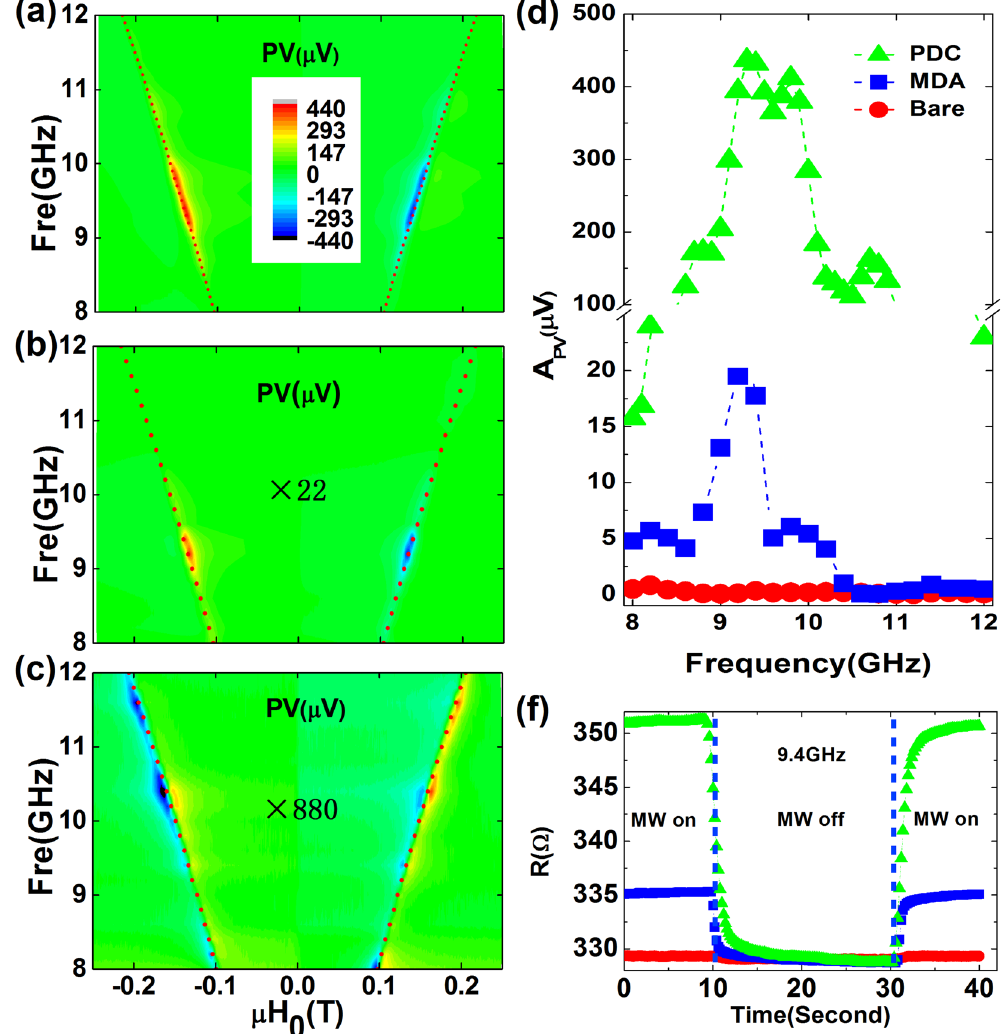
Figure 2. Experimental results. Panels (a)–(c) successively show the two-dimensional PV spectrum as a function of the external magnetic field and microwave frequency for three configurations: PDC, MDA, and bare. The red dashed lines indicate the calculated FMR frequency using Kittel’s formula ω = γ + H H M ( ) . ( d ) The amplitude of microwave photovoltage ( A PV ) as a function of frequency. ( e ) 0 0 0 The change of the sample’s resistance under microwave (9.4 GHz) irradiation with a period of 42 s (width 21 s) at 23 dBm with different configurations (PDC: green solid triangles; MDA: blue solid squares; and bare: red solid